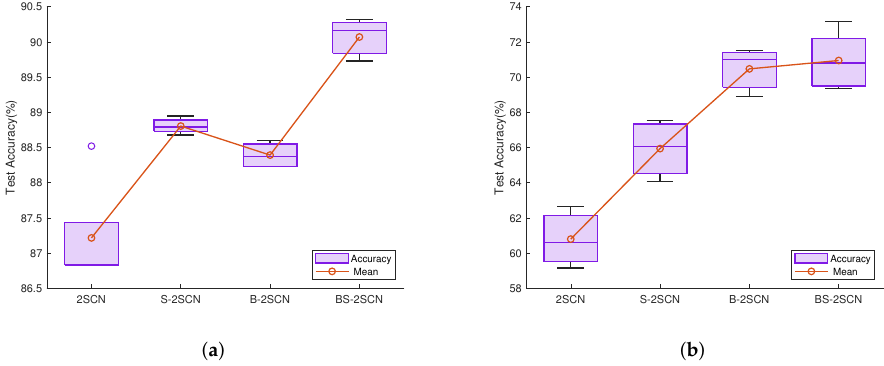
Figure 10. Accuracy distributions and means for ten independent repeated experiments of four groups of subjects on two data sets ( a ) UCF101. ( b )